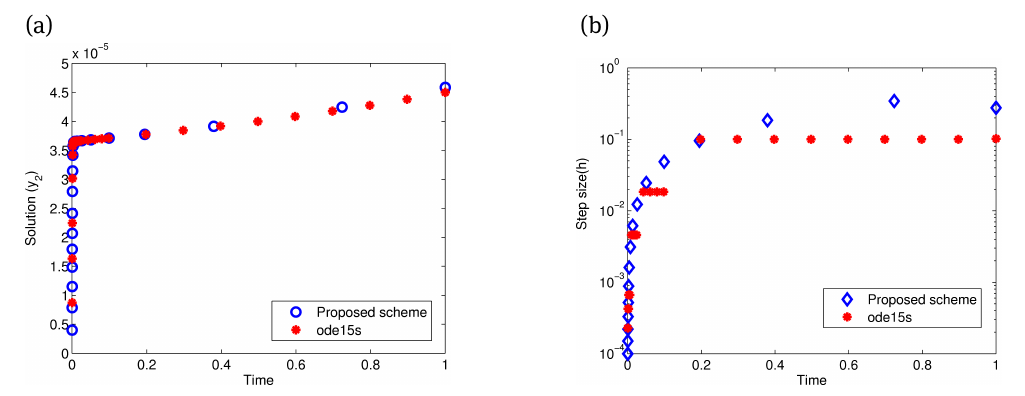
Fig. 1. Comparison of (a) solution and (b) corresponding time step size for proposed scheme and existing method